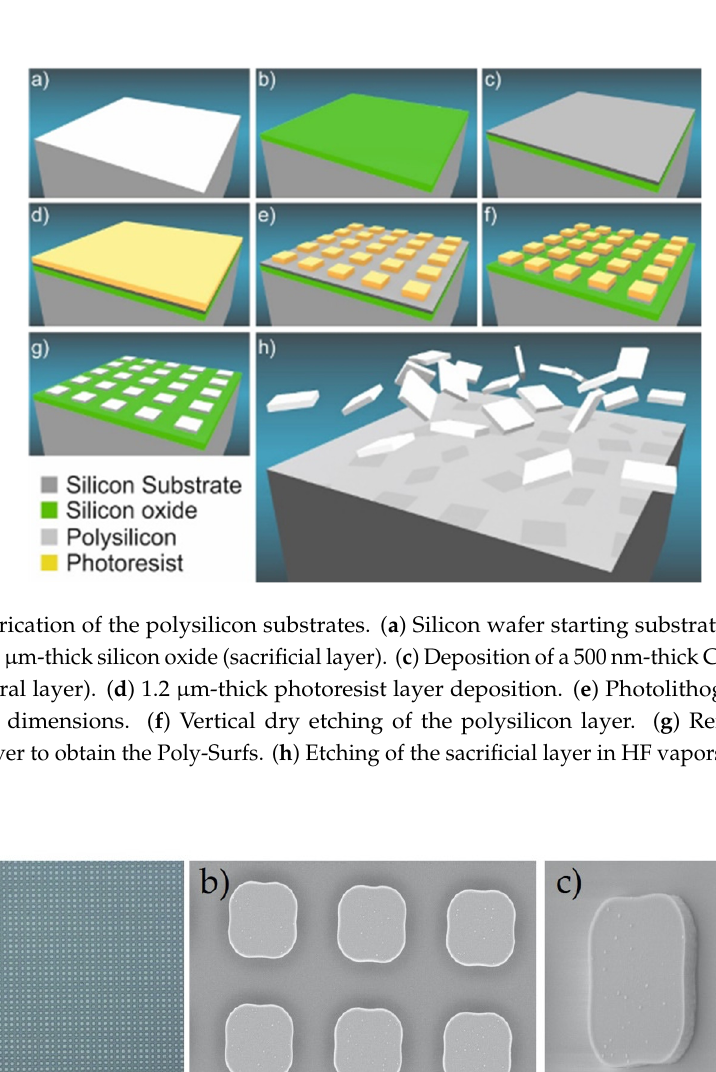
Figure 3. Fabrication of the polysilicon substrates. ( a ) Silicon wafer starting substrate. ( b ) Thermal growing of a 1 µm-thick silicon oxide (sacrificial layer). ( c ) Deposition of a 500 nm-thick CVD polysilicon layer (structural layer). ( d ) 1.2 µm-thick photoresist layer deposition. ( e ) Photolithographic step to define lateral dimensions. ( f ) Vertical dry etching of the polysilicon layer. ( g ) Removing of the photoresist layer to obtain the Poly-Surfs. ( h ) Etching of the sacrificial layer in HF vapors and release of Poly-Si μ Ps.